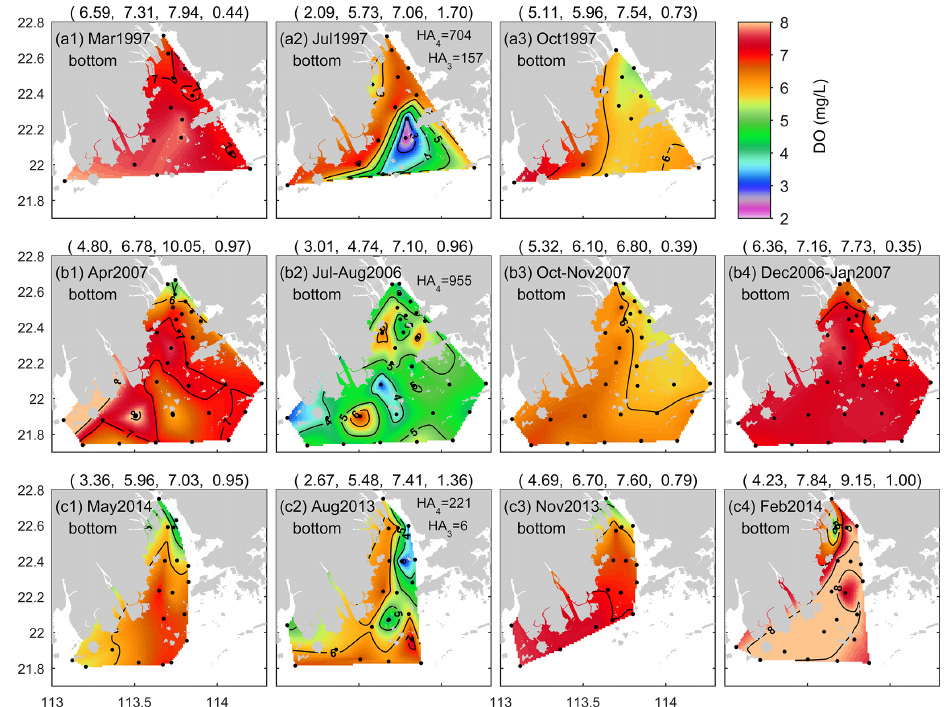
Figure 4. Same as Fig. 3 but for the bottom water. Note that HA 4 , HA 3 , and HA 2 represent the areal extent (km 2 ) with DO < 4, DO < 3, and DO < 2mgL − 1 estimated from the available monitoring data, respectively.